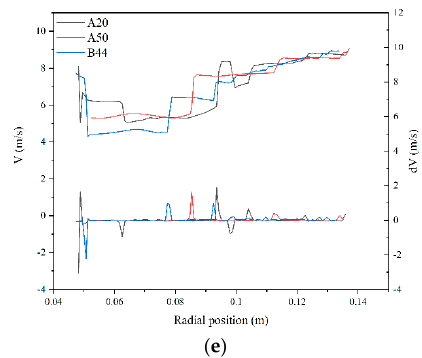
Figure 13. Letter and numbers form the ID of the particle. “A” represents the first stage and “B” represents the second stage. The velocity and the first-order difference of the velocity vary with the radial position: ( a ) Part 1; ( b ) Part 2; ( c ) Part 3; ( d ) Part 4; ( e ) Part 5.